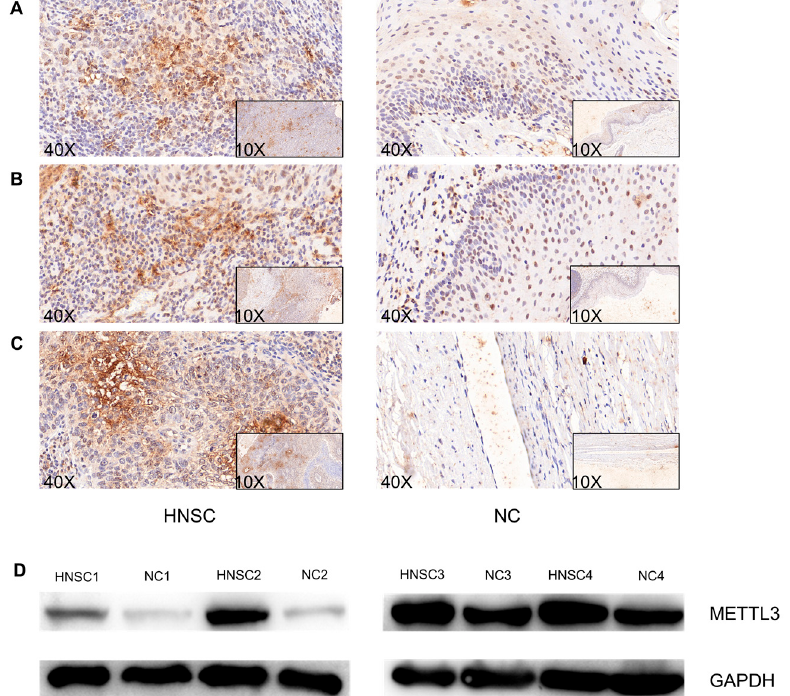
Figure 5. ( A – C ) Representative immunohistochemical images of elevated levels of METTL3 protein in HNSC tissues in our collected tissues. ( D ) Representative Western blot images of elevated levels of METTL3 protein in HNSC tissues in our collected tissues.